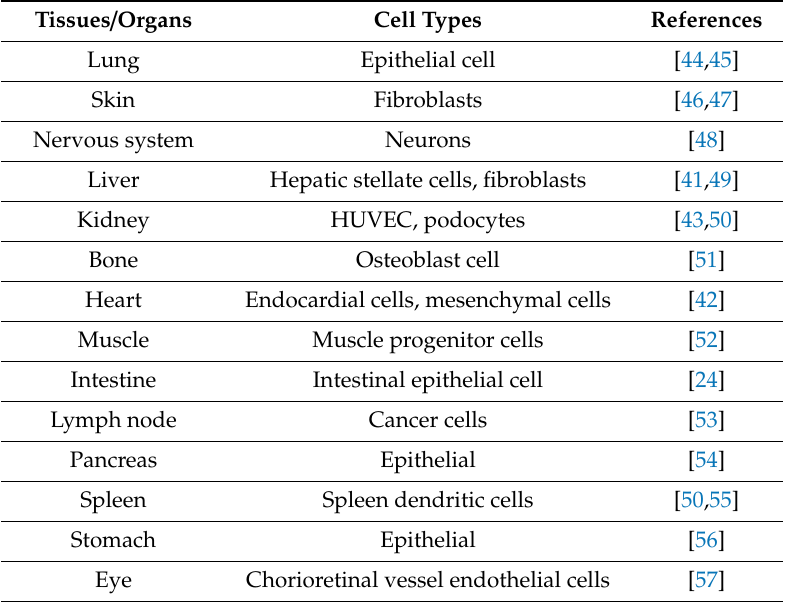
Table 1. Tissue and cell distribution of CCN1.